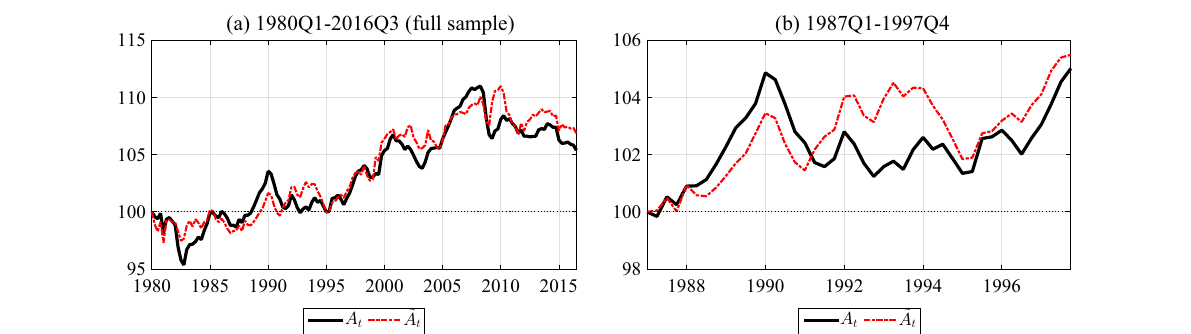
Fig. 21 Robustness: Productivity and utilization-adjusted productivity for ν = 2 . A t and ˜ A t are the efficiency and the utilization-adjusted efficiency wedge, respectively